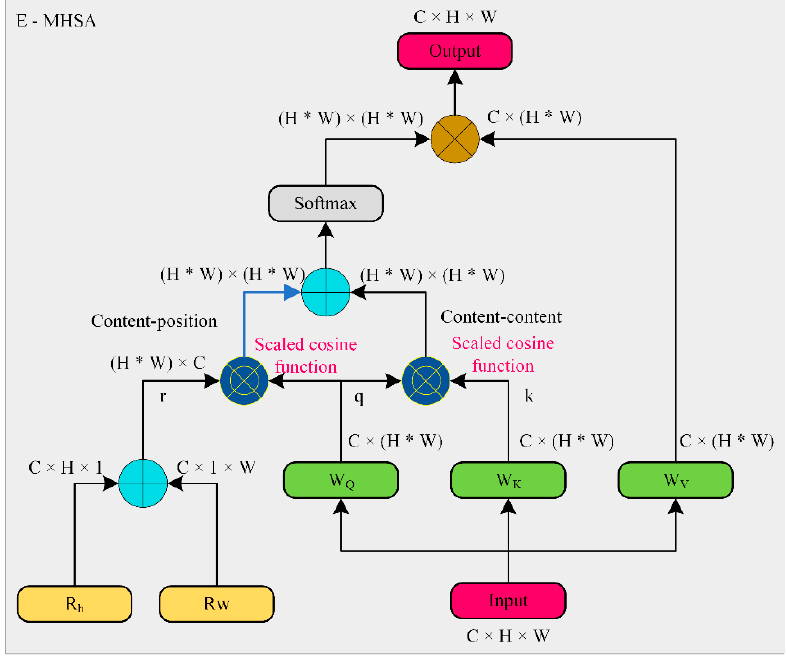
Figure 4. E ‐ MHSA module. While we use 4 heads, we do not show them on the figure for simplic ‐